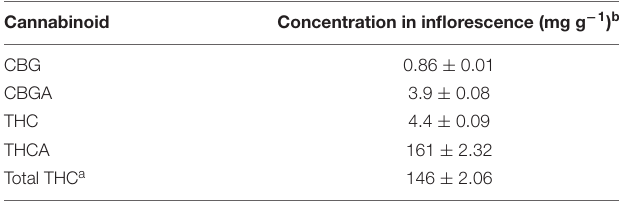
TABLE 6 | Dry inflorescence average cannabinoid contents of Cannabis sativa grown in the deep-water culture system with different NPK concentrations in the solution.